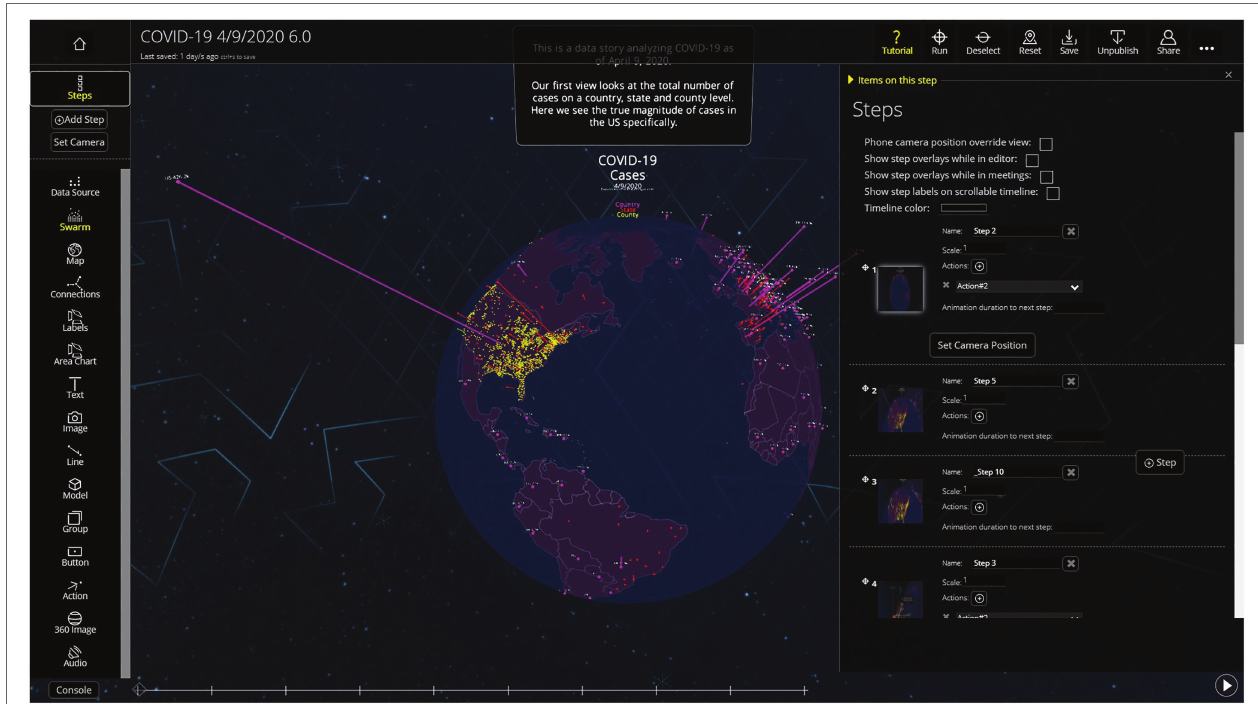
FIGURE 7 | Flow Immersive Web-Based Editor. This is how all of the visualizations and interactive experiences are